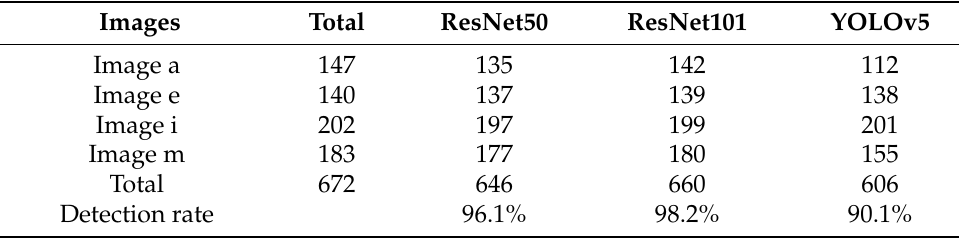
Table 3. Different model detect and segment